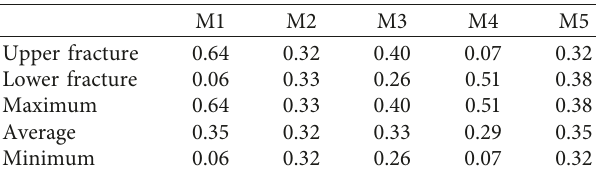
Figure 1: Test device and preparation of samples. (a) Self-made splitting mold; (b) marble fracture surfaces and single-fractured samples; (c) 3D laser scanning device; (d) 3D morphology of sample M1 upper fracture; (e) 3D morphology of sample M1 lower fracture. Table 1: S − 2 dp of five rock fractures (cm